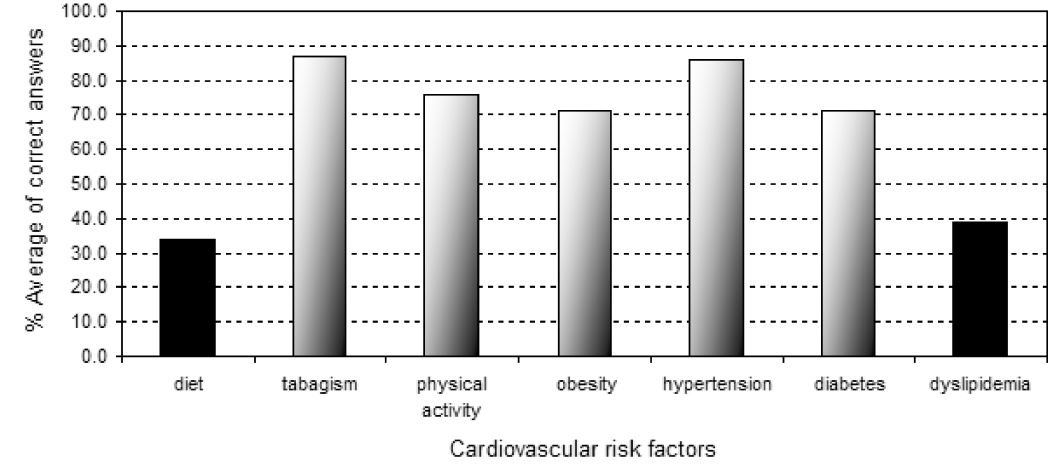
Figure 1 - Patient knowledge about cardiovascular risk factors: % average of correct answers of 75